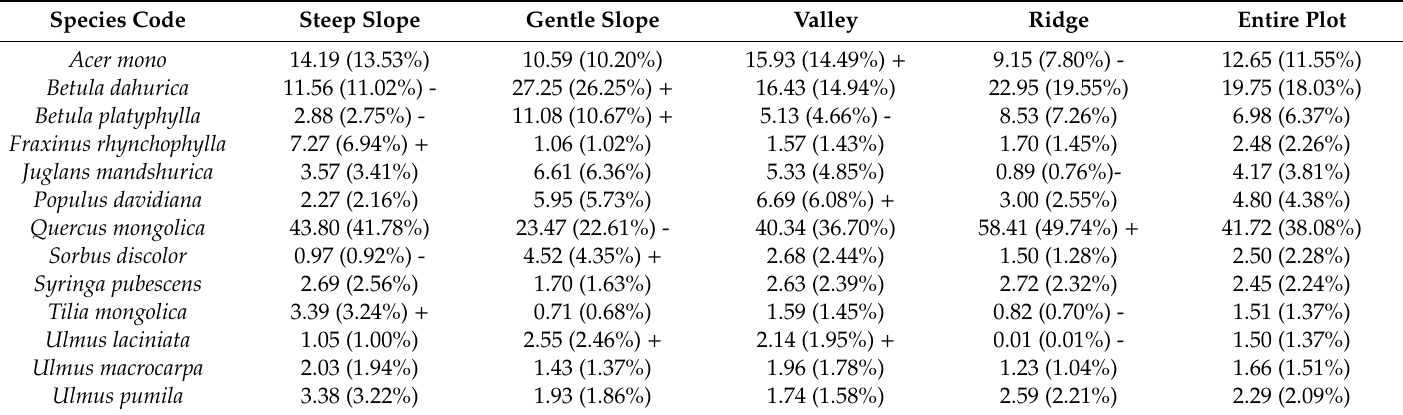
Table 2. Relative species’ contributions to biomass in the four di ff erent habitats and the entire 20-ha DLS plot based on torus-translation test